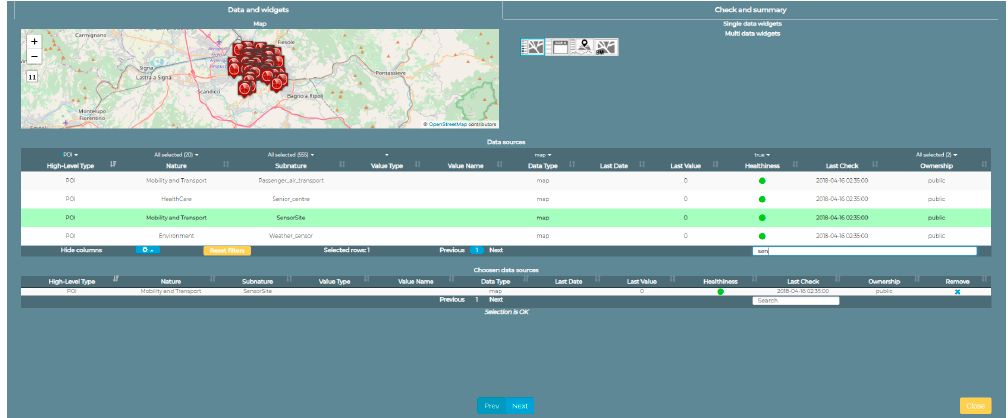
Figure 15 . Creation of a widget (the map with the selectors of the various POIs) through the Wizard. In the example, traffic sensors are selected as POIs.